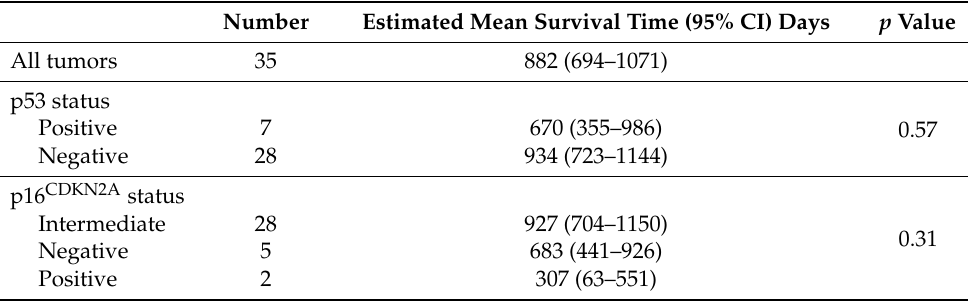
Table 2. Survival times of dogs with malignant mammary gland